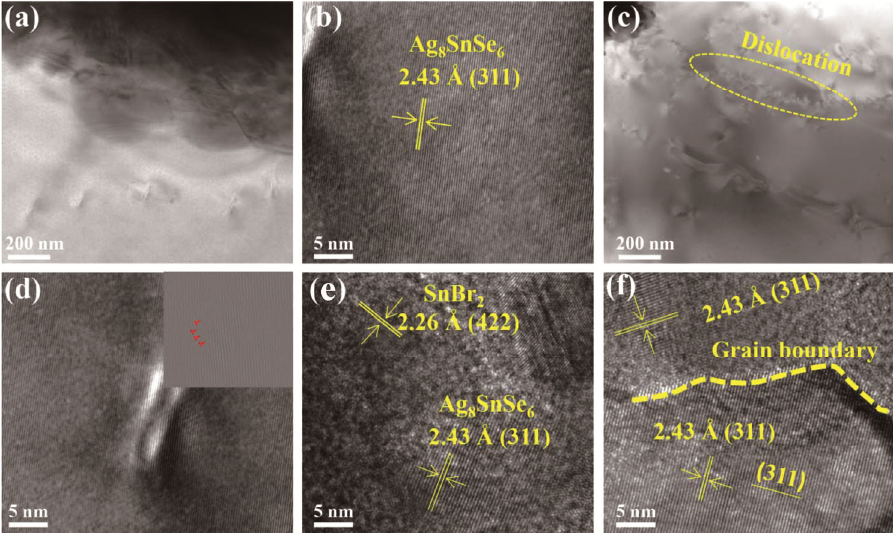
Fig. 3 Low-magnification TEM images of the samples: (a) Ag 8 SnSe 6 and (c) Ag 8 Sn 1.03 Se 5.94 Br 0.06 ; high-magnification TEM images of the samples: (b) Ag 8 SnSe 6 and (d–f) Ag 8 Sn 1.03 Se 5.94 Br 0.06 .